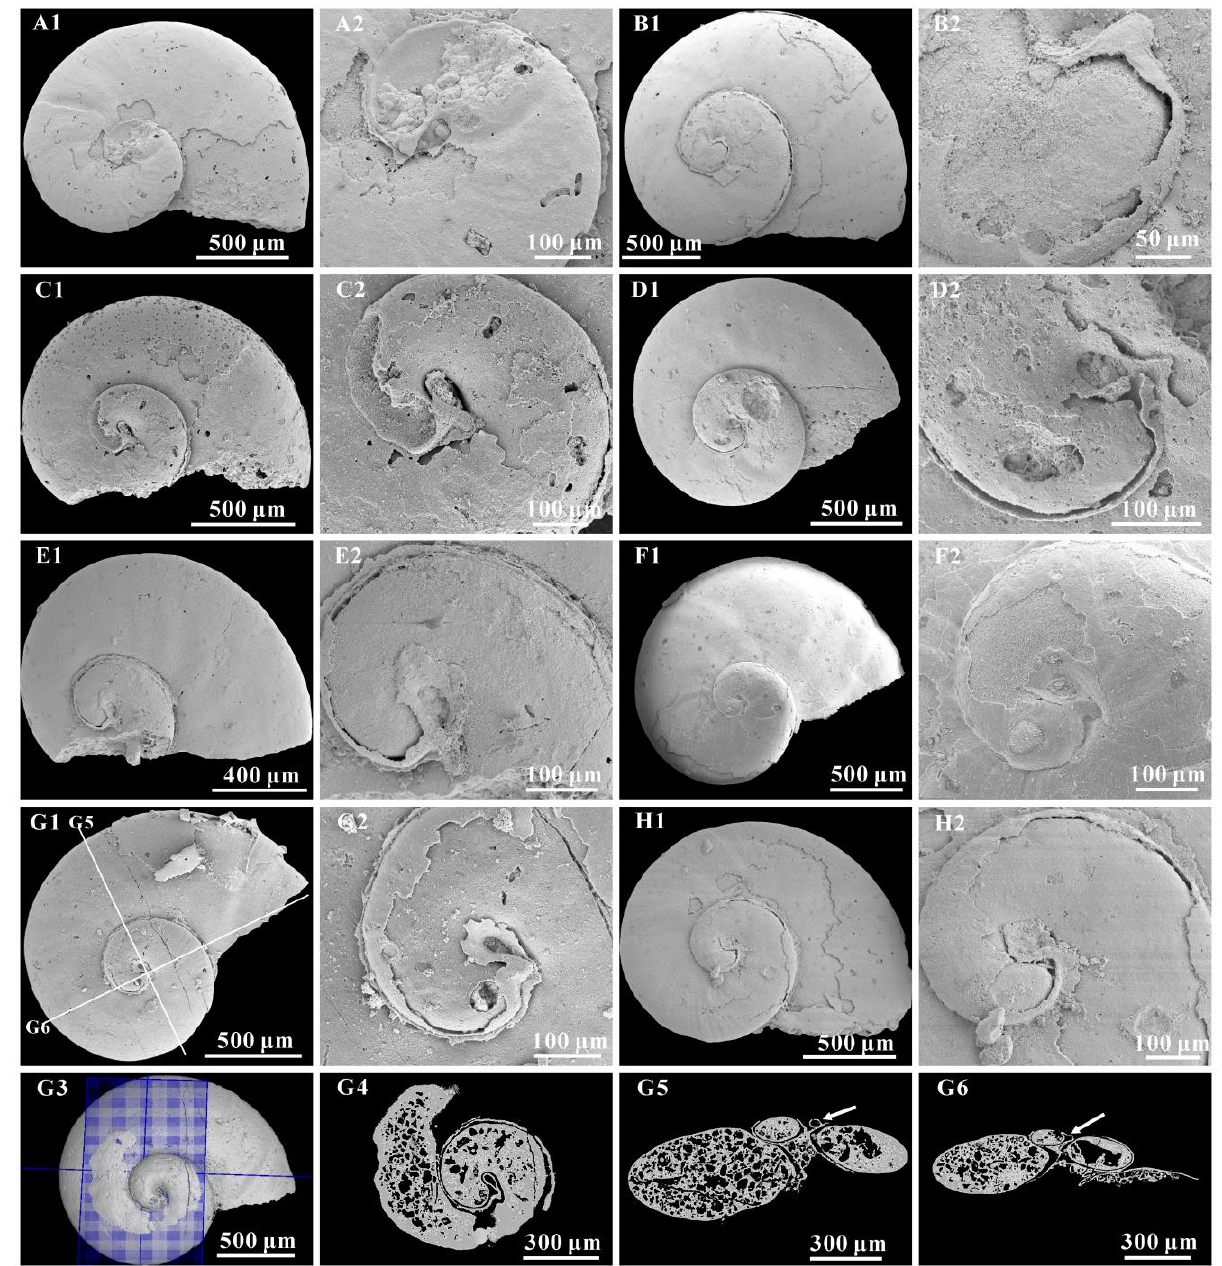
Figure 4. The mucro on the protoconch of Aldanella attleborensis . ( A ‒ H ), internal molds with partial external coating, apical views, CUBar207-9, CUBar207-14, CUBar98-33, CUBar115-14, CUBar208-9, CUBar98-26, CUBar208-7, and CUBar22-4, respectively; ( A2 , B2 , C2 , D2 , E2 , F2 , G2 , H2 ) magnifications of ( A1 , B1 , C1 , D1 , E1 , F1 , G1 , H1 ), showing variation of mucros. ( G3 ‒ G6 ), Micro-CT tomography of the ( G1 ); ( G3 ), 3D volume rendering; ( G4 ), virtual intersection, indicated by the blue flat in ( G3 ); ( G5 ), virtual intersection traversed the mucro, indicated by the line in ( G1 ); ( G6 ), virtual intersection along the mucro, indicated by the line in ( G1 ), white arrows indicate the mucro position. Specimens from the Yanjiahe